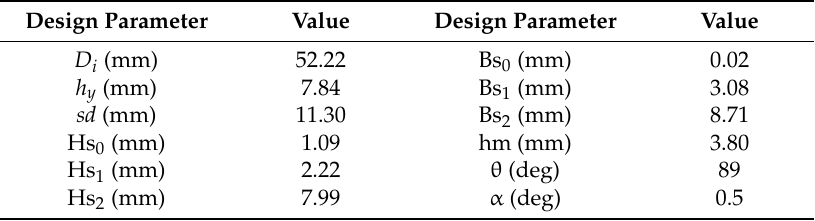
Table 8. Finial solutions of the MOP.